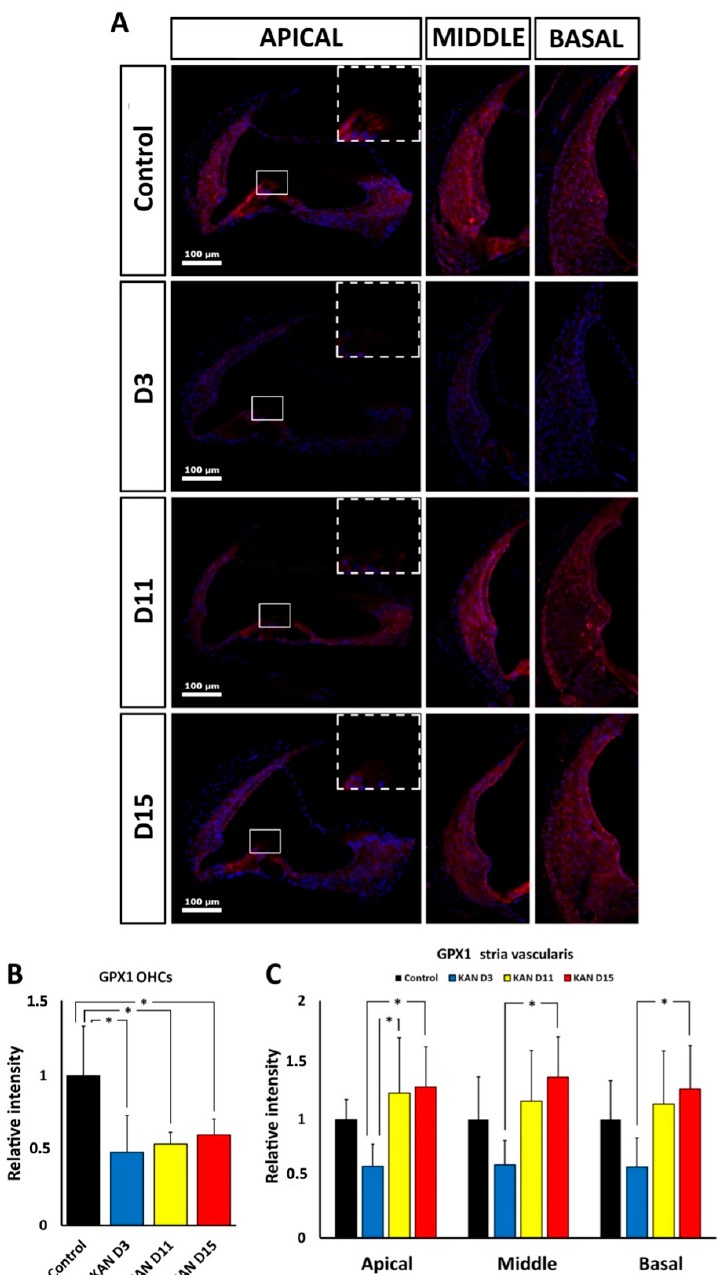
Figure 10. ( A ): Fluorescent immunolocalization of GPx1 (magenta) in the cochlea after kanamycin (KAN) ototoxicity and corresponding untreated control. Nuclei are counterstained with DAPI (blue). The first vertical panel at the right of the figure shows the OHC region of the apical turn (square, enlarged in the upper left corner of the photomicrograph). The lateral wall region with the stria vascularis can also be observed. The next two vertical panels show the lateral wall, including the stria vascularis of the middle and basal turns at D3, D11 and D15 after kanamycin treatment. ( B ): Relative intensity levels of GPx1 in the OHC region of the apical turn during treatment with kanamycin, at D3, D11 and D15. ( C ): Relative intensity levels of GPx1 immunolabeling in the stria vascularis of the apical, middle and basal turns during ototoxic treatment with kanamycin, at D3, D11 and D15. At D11 and D15, relative intensity values are statistically not significantly different to those measured in controls. Asterisks indicate statistical significance values, as specified in Section 2.6, Materials and